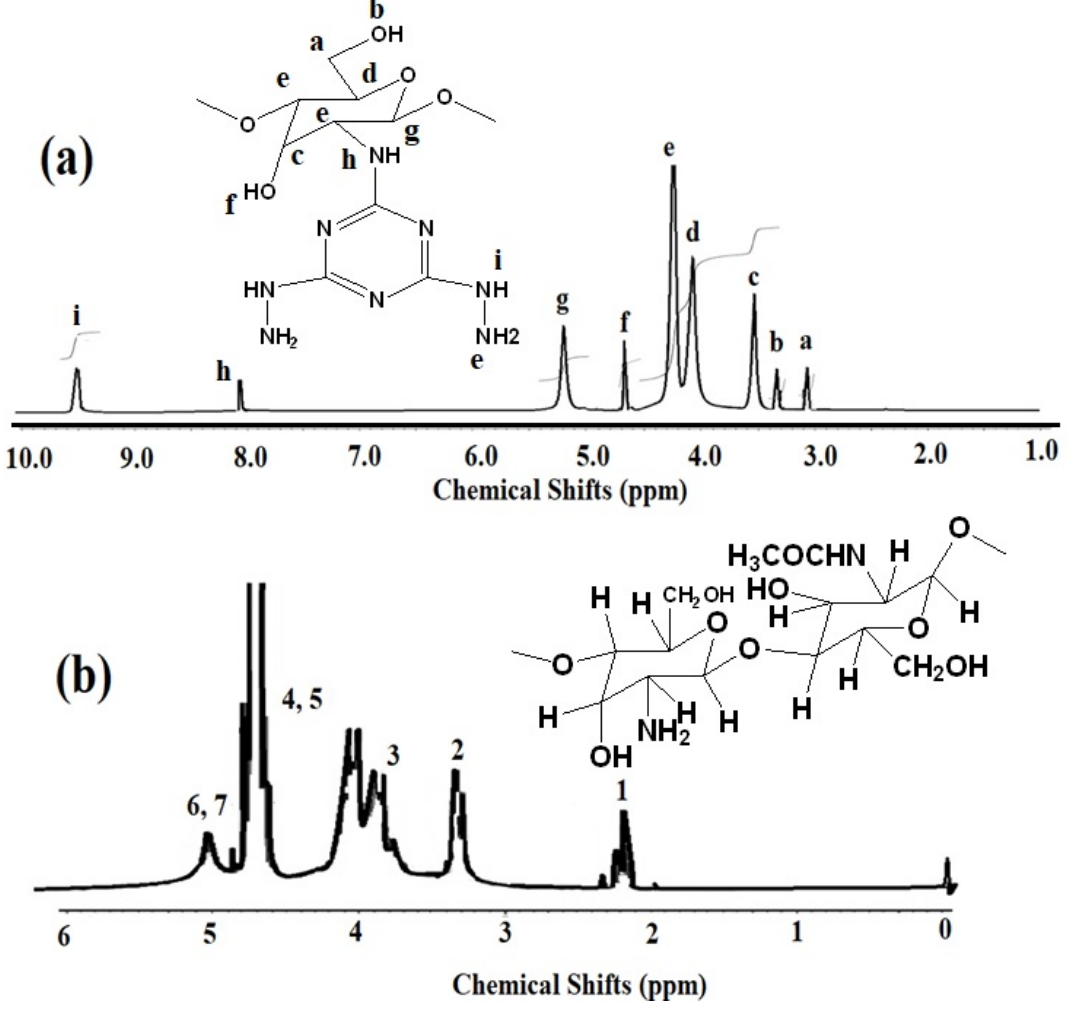
Figure 1. 1 HNMR spectrum of ( a ) chitosan modified with triazine dihydrazide moiety (HCh-TH2) Figure and ( b ) high chitosan (HCh).